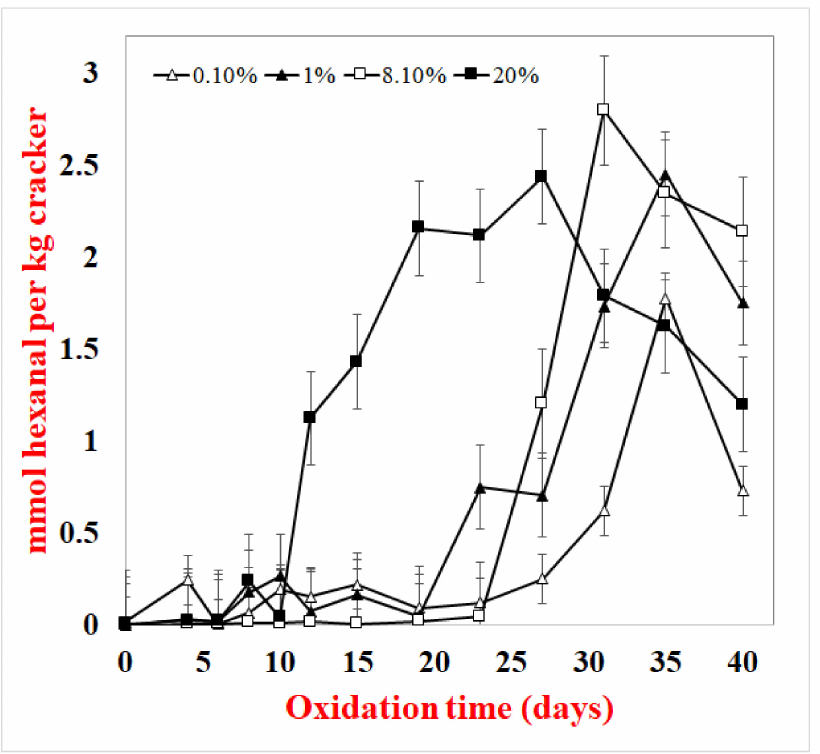
Figure 6. Hexanal formation in of crackers with different fat contents at 55 ◦ C. Data points are the average of 3 measurements ± standard deviations.